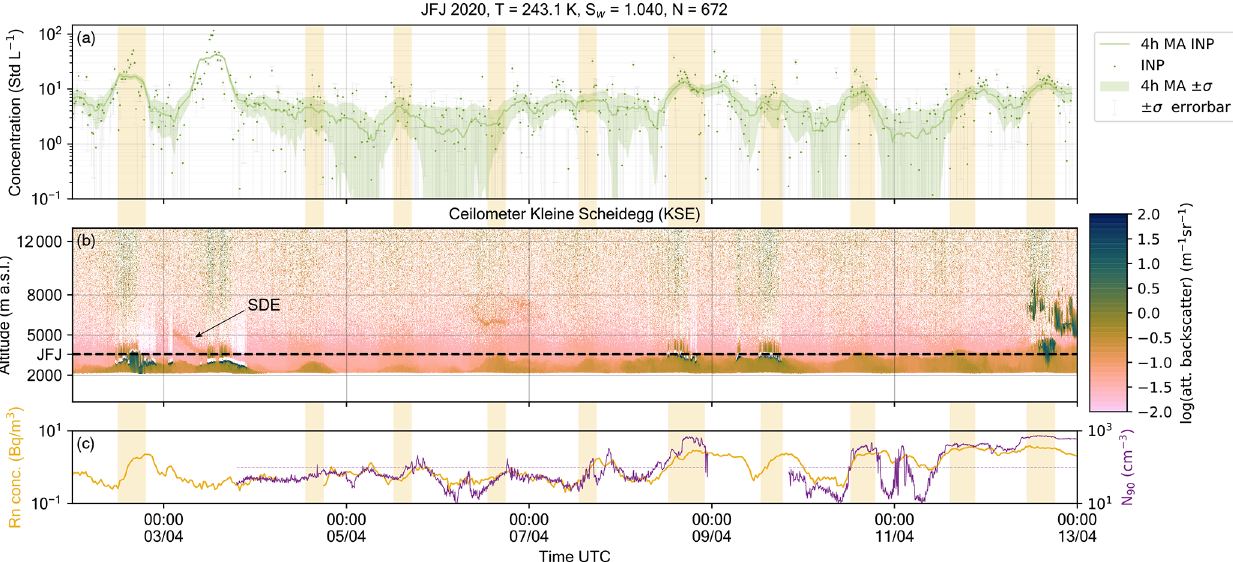
Figure A3. INP concentrations at JFJ, including a 4h moving average (MA) and a 1 σ counting uncertainty (a) , attenuated backscatter from the ceilometer at Kleine Scheidegg (b) , and radon and N 90 concentrations (c) during a convective period between 2 and 13 April 2020. Note the peaks in INP concentrations coincide with the diurnal swelling of boundary layer air masses past the altitude of JFJ, highlighted by the orange shading and indicated by the increase in backscatter from ≤ 10 − 0 . 8 to ≥ 10 − 0 . 5 m − 1 sr − 1 .